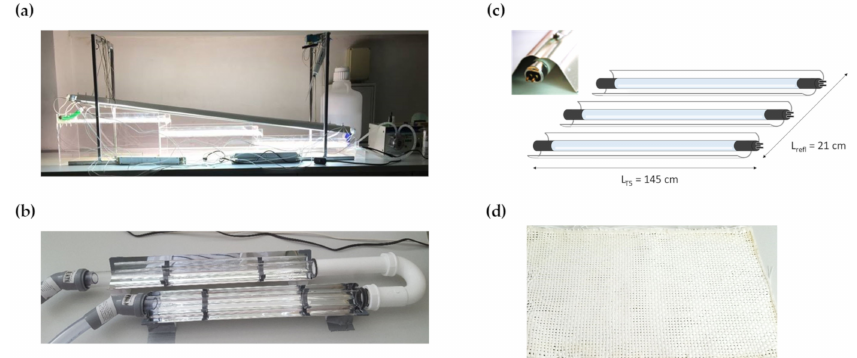
Figure 1. ( a ) The flat-plate cascade reactor (FPCR) reactor; ( b ) the compound parabolic collector (CPC) reactor; ( c ) schematics of custom-made panel with linear fluorescent lamps; ( d ) the image